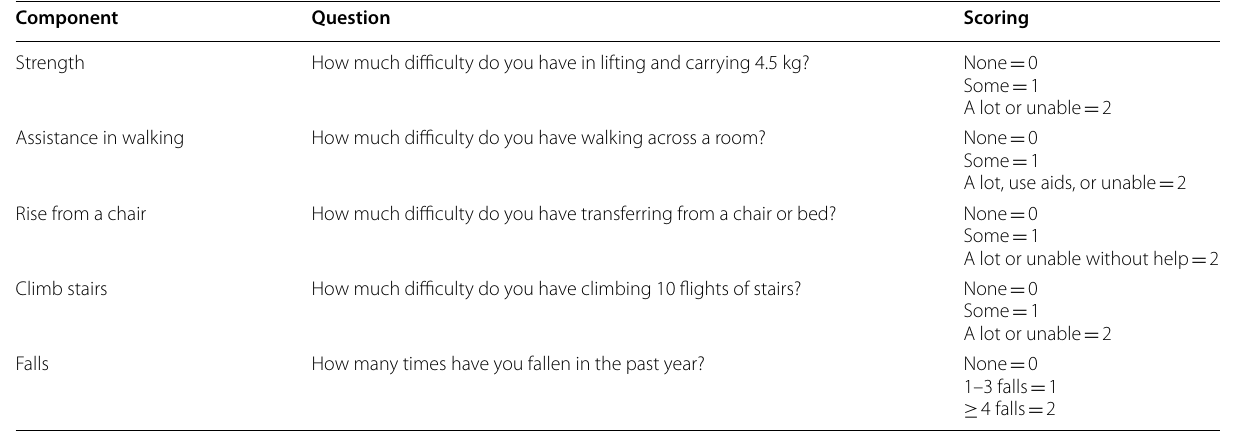
A score 4 is suggestive of sarcopenia ≥